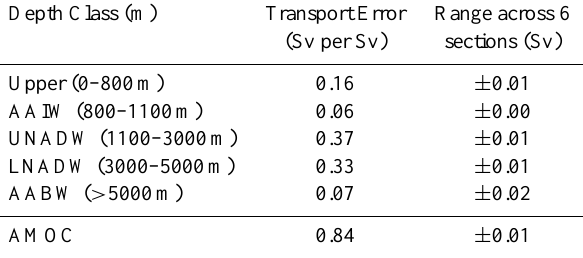
Table 2. Mid-ocean transport error in depth classes associated with a 1Sv error in combined Ekman and Florida Straits transport. An error in combined Ekman and Florida Straits transport leads to an error in reference level velocity and, therefore, a transport error pro- portional to depth class area. The transport error given is a mean er- ror for the six hydrographic section, the final column gives the range of values about the mean for the 6 sections. Note that the AABW shows the greatest range in transport error because differing section bathymetry has the greatest effect on the area of this depth